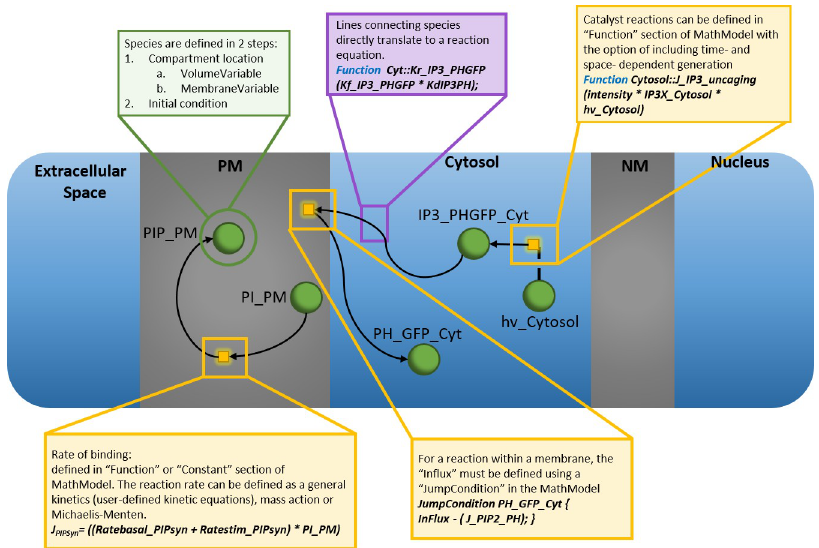
Fig 2. Relationships of the elements of a mathematical model. The schematic visually represents the components of the mathematical model: species (green circle), reaction rates (yellow squares), compartments (Extracellular Space, Cytosol, and Nucleus), and membranes (PM and MM). The arrows connect species together with reaction rates and also define the mass conservation